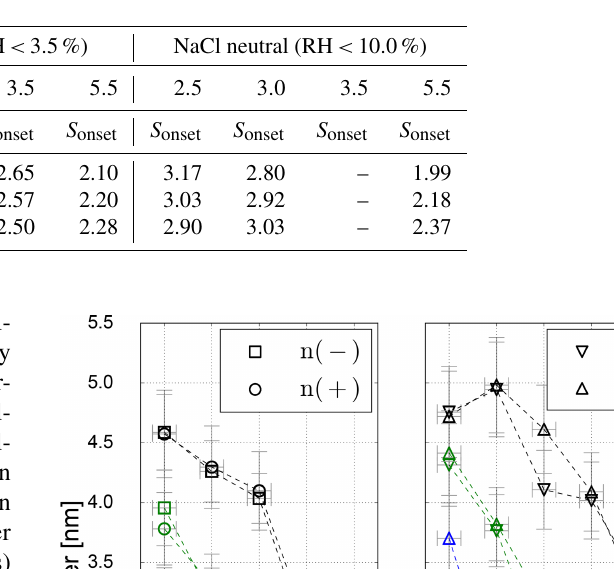
Table 3. Calculated maxima of the CPC saturation ratio profiles S max for low-, standard- and high-temperature settings (Tauber et al., 2019), in comparison to the extrapolated S onset as measured by the SANC.